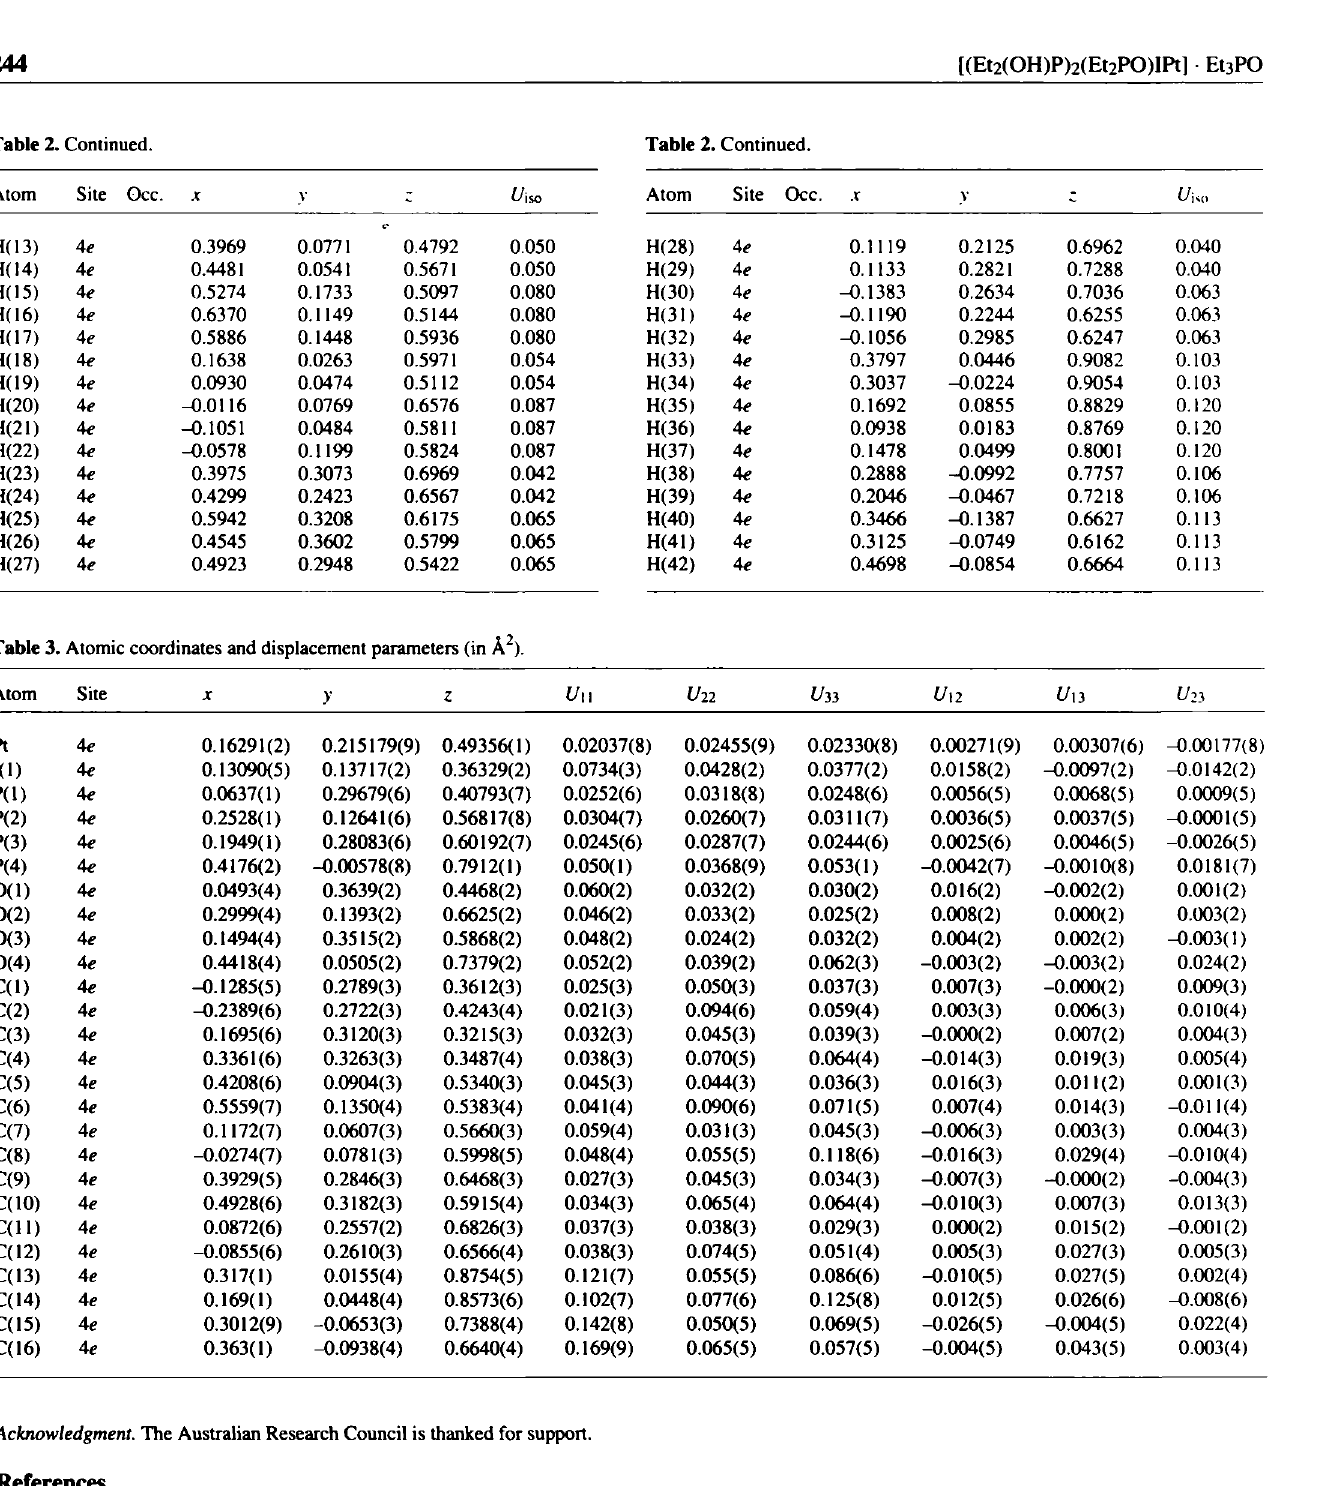
Table 3. Atomic coordinates and displacement parameters (in Ä 2